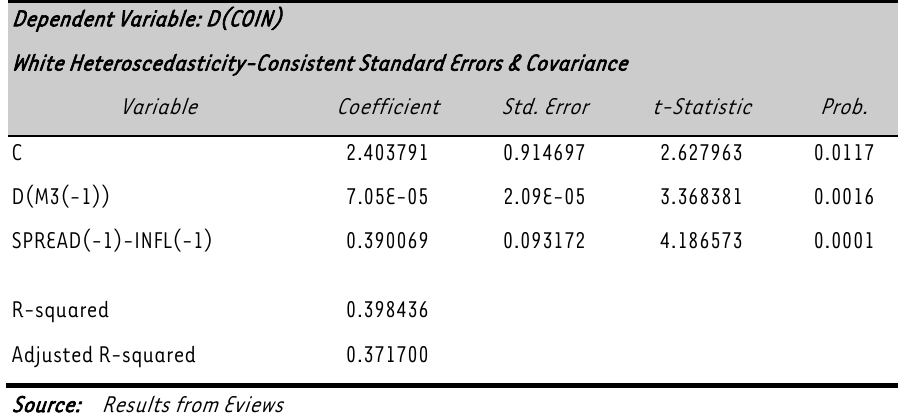
FIGURE 3: Domestic component of the financial indicator